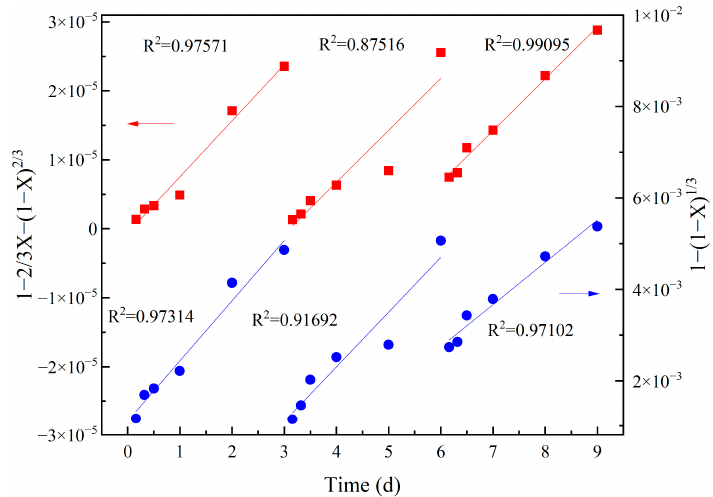
Figure 3. Kinetic model of vanadium leaching controlled by diffusion and chemical reaction in Bioreactor. Left axis provides measurement label of the diffusion model (red) and right axis corresponds to the chemical-reaction model (blue), as indicated by arrow.